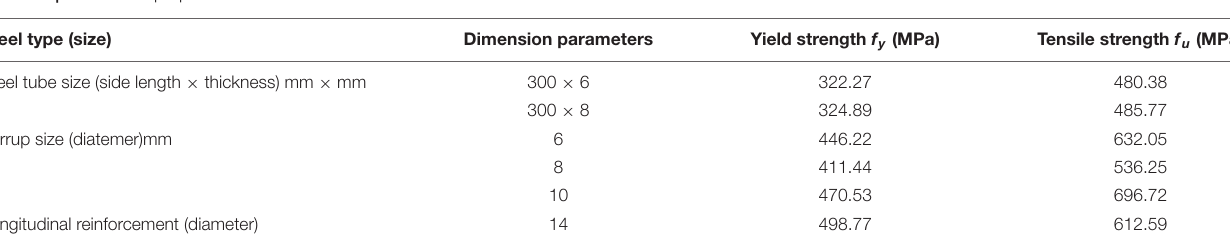
TABLE 2 | Mechanical properties of